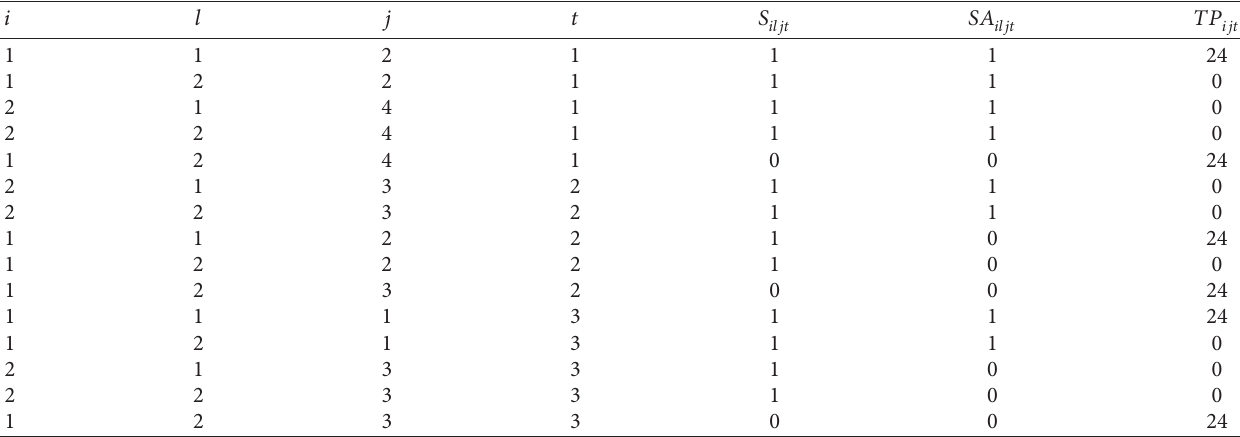
Table 9: Small dataset results of the base LSSP MILP: scheduling.